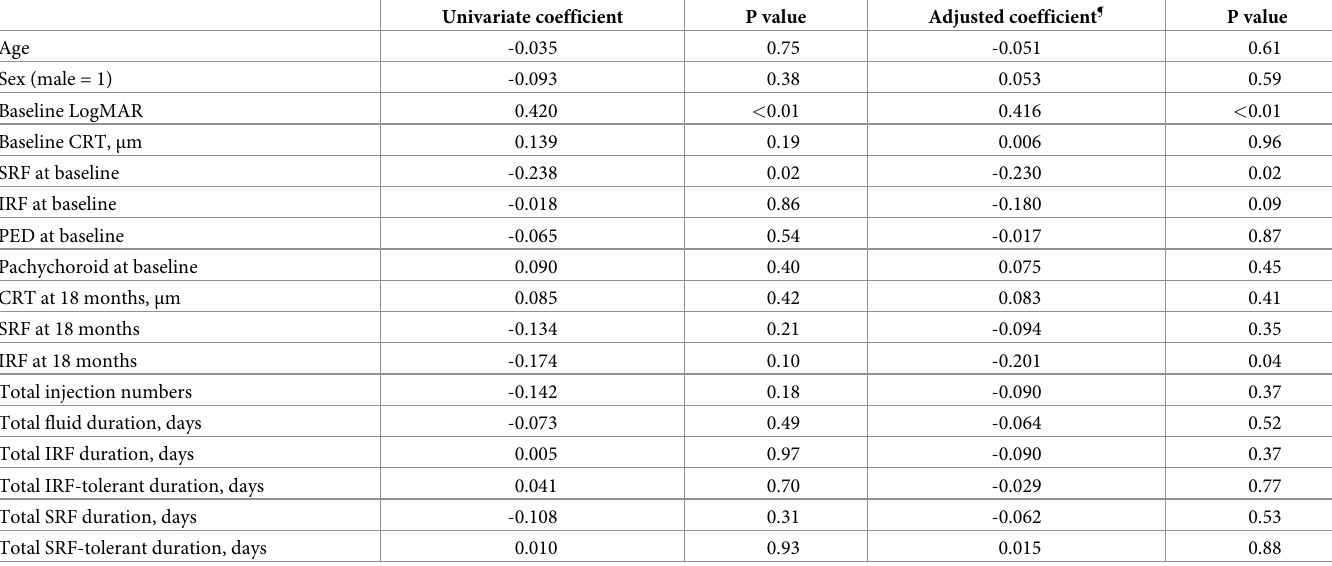
Table 5. Regression analysis of factors associated with changes in visual acuity at 18